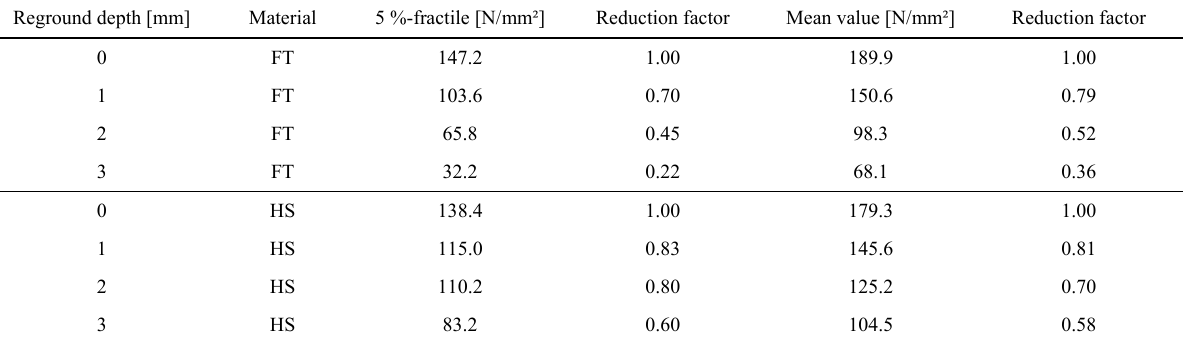
Table 6: Calculated reduction factor depending on the 5 %-fractile